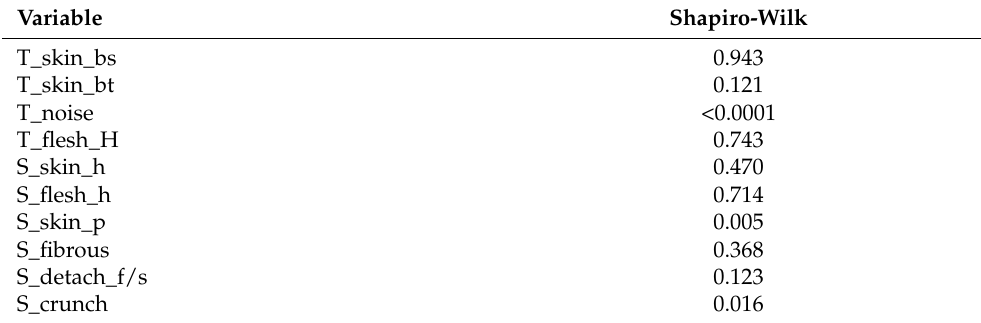
Table 3. Normality test of the